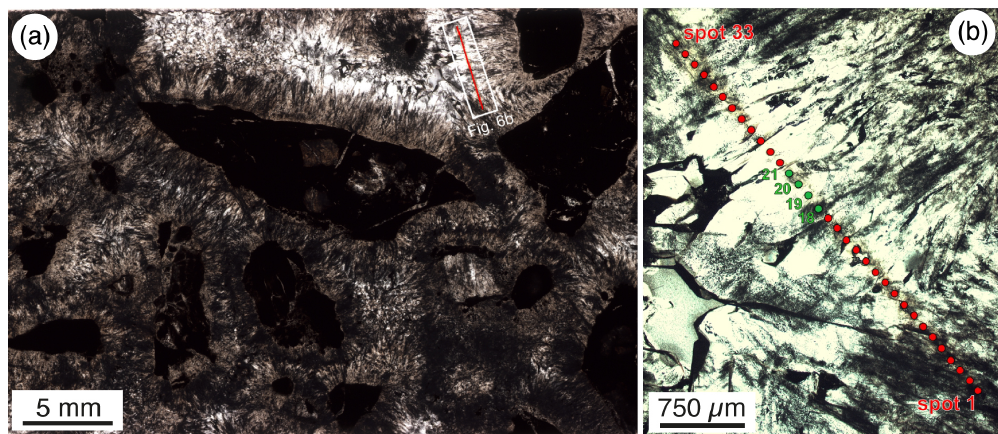
Figure 6. (a) Fluid wafer scan of angular to sub-rounded and quartz-coated gouge fragments from the quartz zone of the Rusey Fault Zone. The red line shows the analyzed LA-ICP-MS array. The white rectangle indicates the position represented in Fig. 6b, in which quartz grains with and without feathery textures have been investigated. (b) Measured LA-ICP-MS spots are indicated by red dots and spots on a single quartz grain for detailed analysis are marked by green dots (18 to 21). Oriented sample TY39X1, II pol.